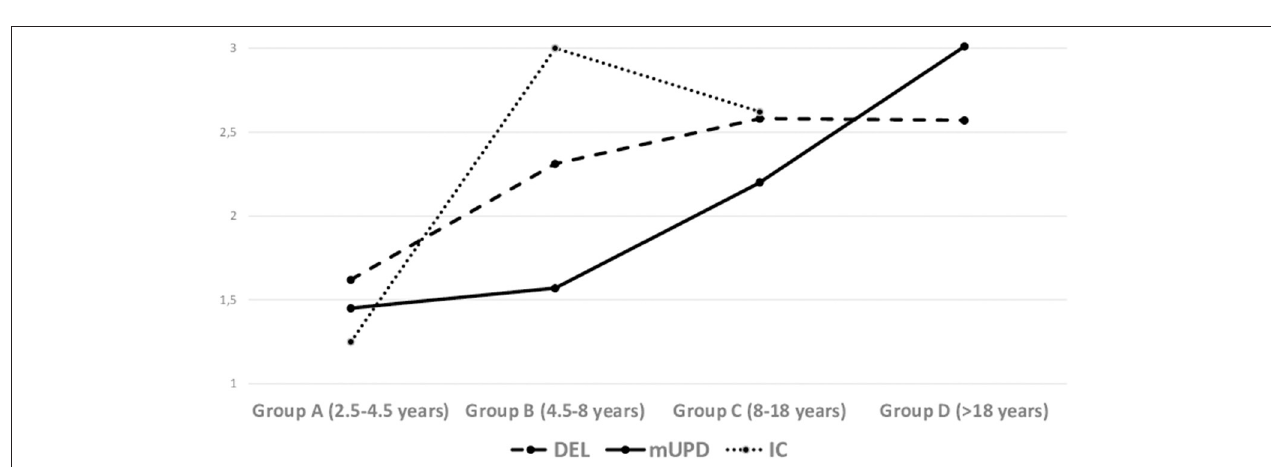
FIGURE 3 | Comparisons of hyperphagia subdimensions by weight-status. Values on the Y-Axis express the mean values of each dimension.